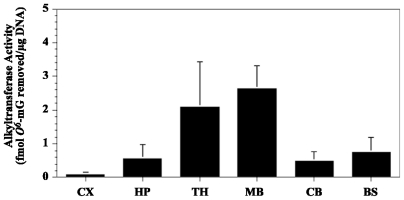
O6-Methylguanine methyltransferase (MGMT) activity in various brain regions of neonatal mice. Protein extracts (100 μg) from postnatal (6–8) brain tissue of wild type (C57BL6) mice (n = 3) were incubated with [3H]-methyl-DNA and the amount of [3H] O6-methylguanine determined by HPLC with liquid scintillation counting. Values are the mean ± standard error. CX = cortex, HP = hippocampus, TH = thalamus, MB = midbrain, CB = cerebellum, BS = brainstem (graph of unpublished data kindly provided by S.L. Gerson, Case Western Reserve University, Cleveland, OH, USA).